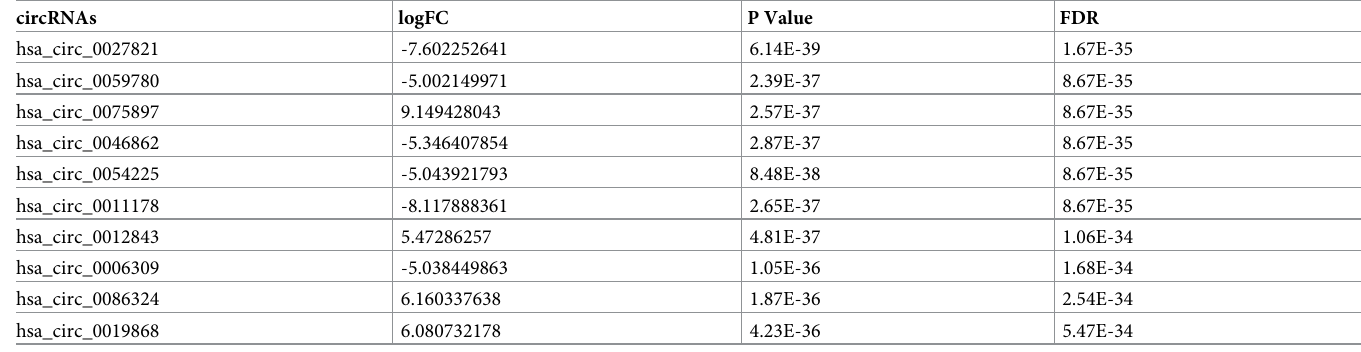
Table 1. Top 10 differential circRNAs for prostate